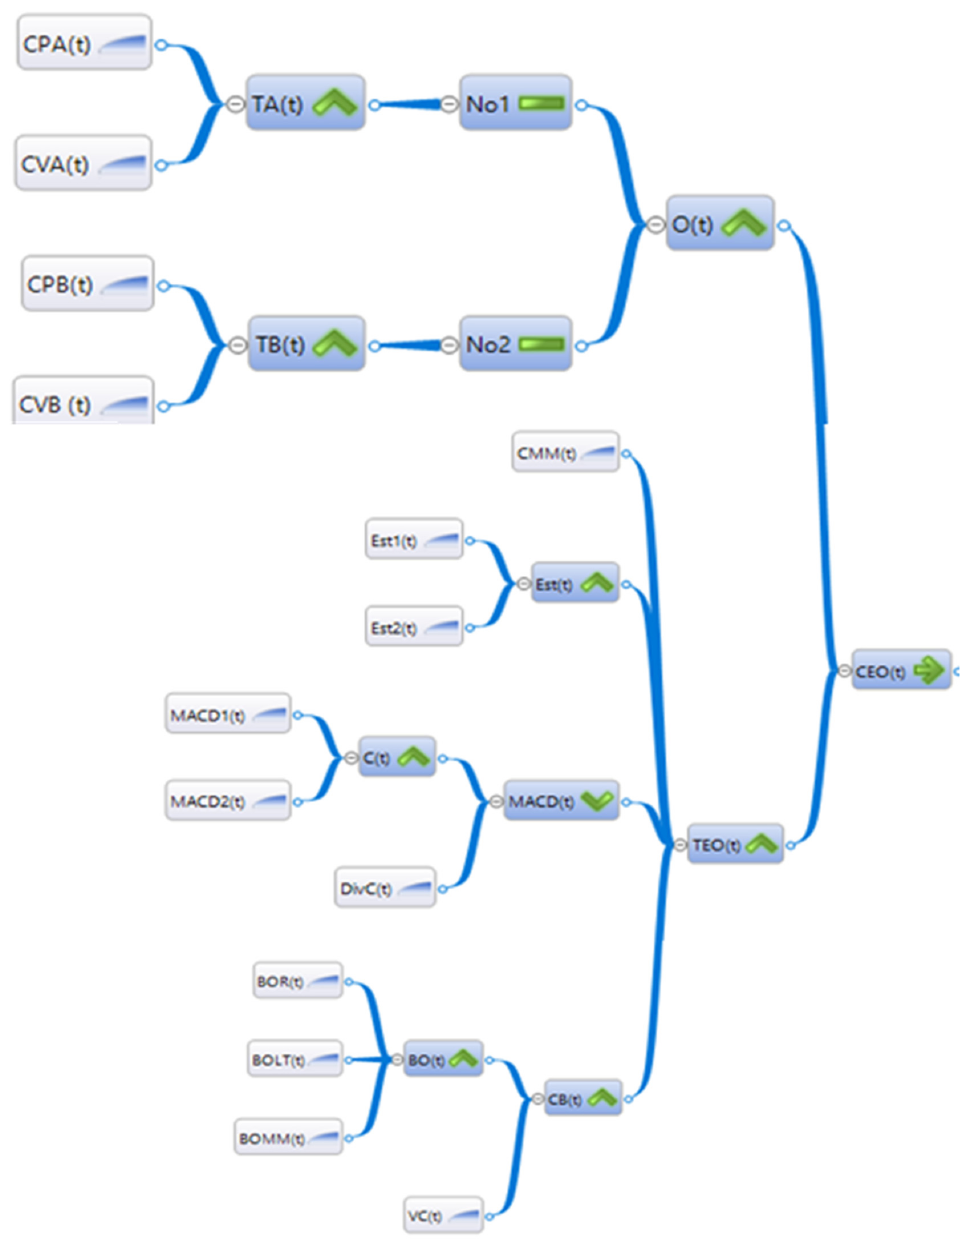
Figure A1. Logical tree representing the truth degree of the predicate “there are good oscillation conditions for buying at time t ”, CEO ( t ).